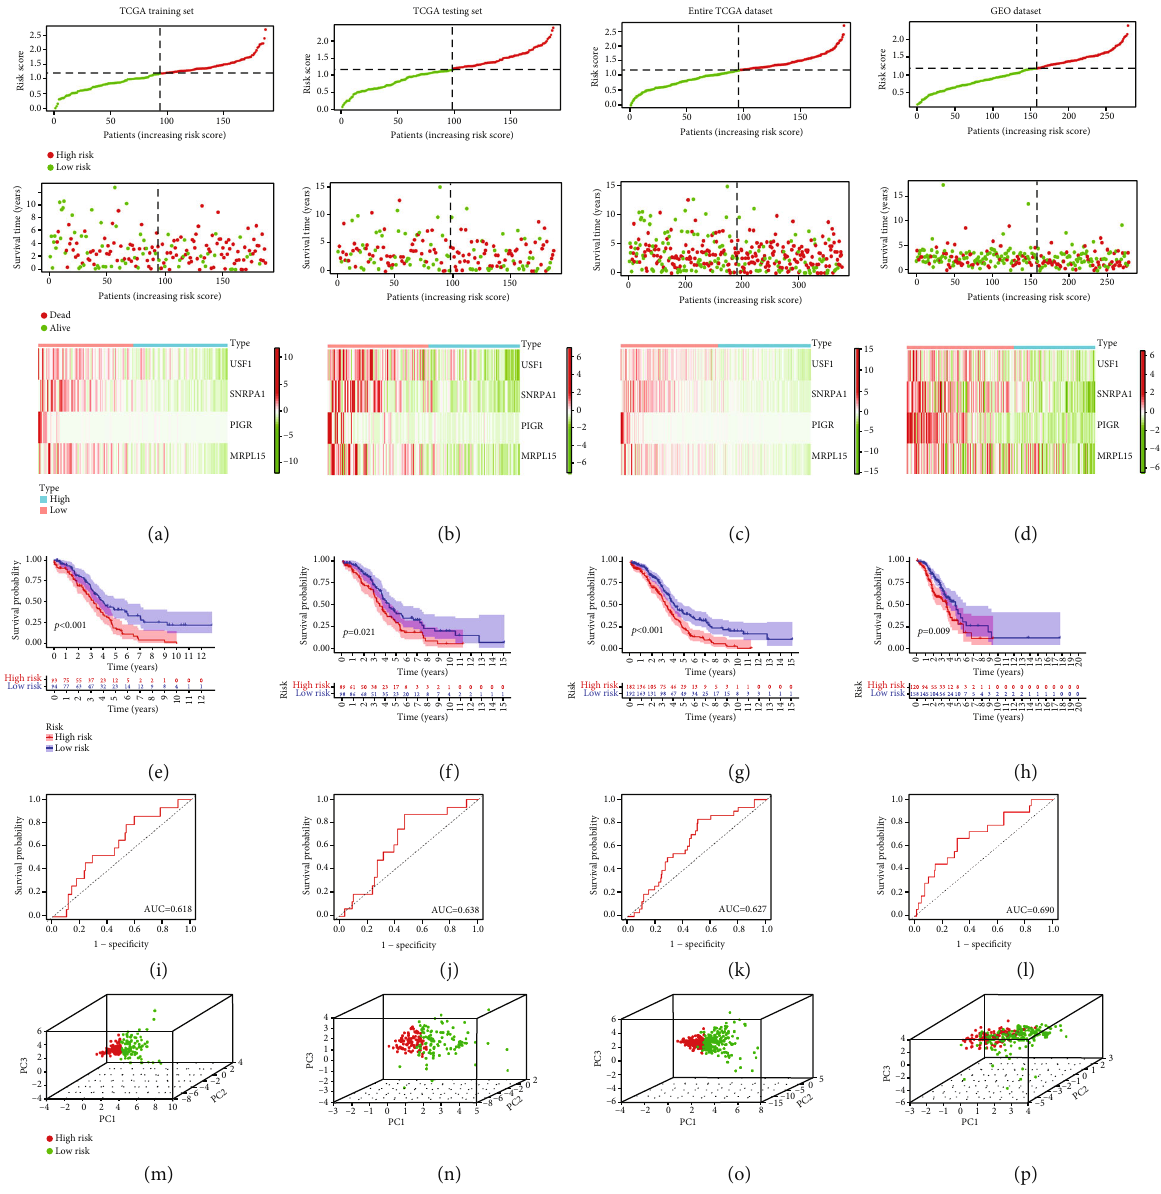
Figure 2: Prognostic analysis of exosome-related gene prognostic risk models in TCGA training set, TCGA testing set, entire TCGA dataset, and GEO dataset. (a – d) Distribution of risk scores, survival status, and expression of four prognostic genes in the four datasets. (e – h) In the four datasets, Kaplan-Meier analysis was used to compare the overall survival of patients in the high-risk and low-risk groups ( p < 0 : 05 ). (i – l) ROC curves for the predictive power of prognostic risk models in the four datasets. (m – p) Plots of principal component analysis in the four